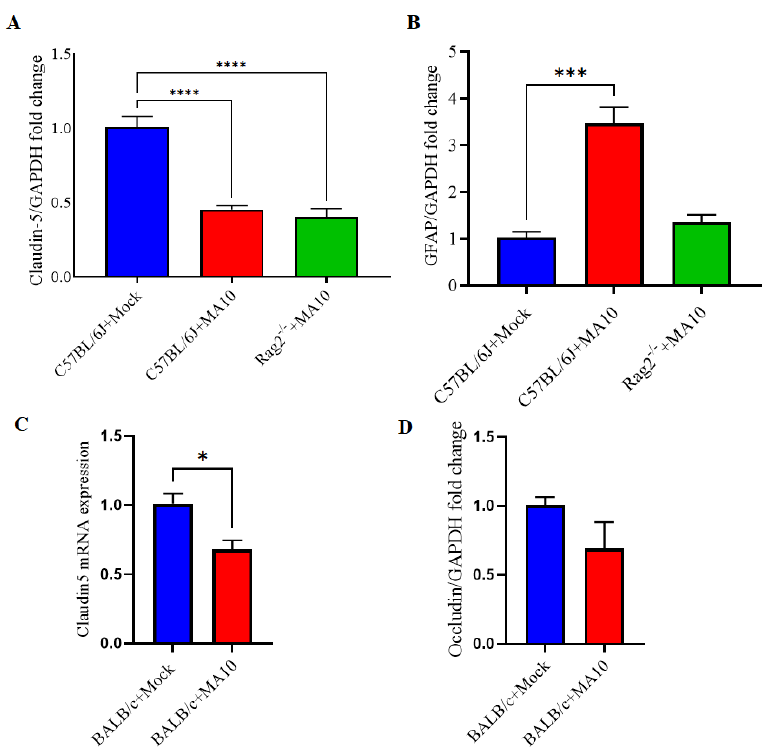
Figure 3. mRNA expression of Claudin-5 is decreased, and GFAP increased in the brains of mouse-adapted SARS-CoV-2 (MA10) infected mice. 10-week-old male C57BL/6J, BALB/c and Rag2 − / − mice were inoculated via the intranasal route with mock or MA10 strain of SARS-CoV-2 (1 × 10 5 TCID 50